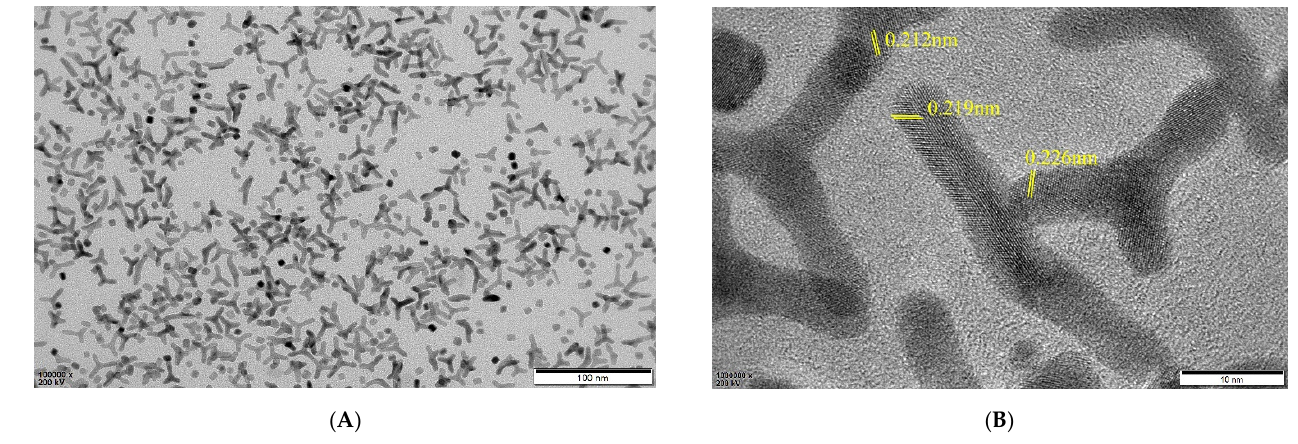
Figure 2. TEM images of PdAuCu NPs at low ( A ) and high magnification ( B ).